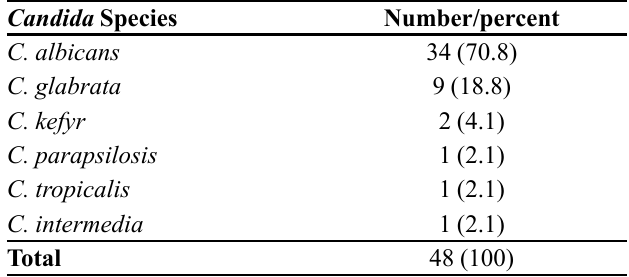
TABLE I - Candida species isolated from oral specimens of